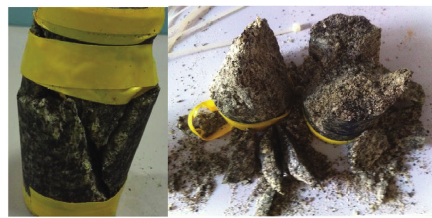
1 – σ 3 ) and strain ( ε